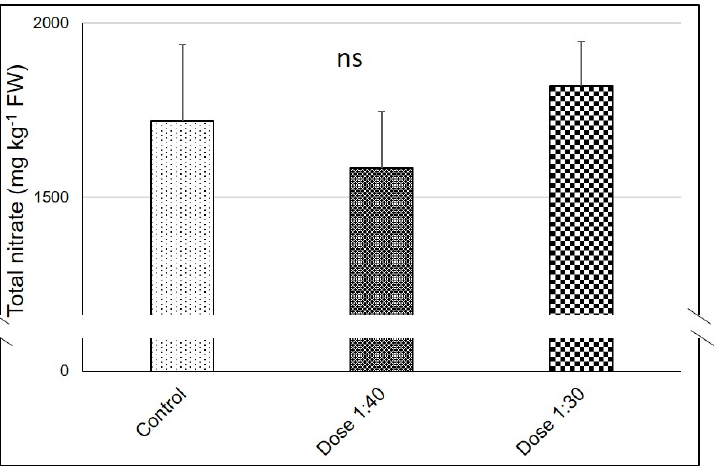
Figure 2. Effect of Moringa oleifera leaf extract (MLE) foliar application on total sugars ( a ) (mg g − 1 FW) and ascorbic acid (Asc) ( b ) (mg g − 1 FW) of radish baby leaf. Data are means ± standard error ( n = 3). Three biological replicates were used for the analysis. Different letters indicate significance at p < 0.05 according to Tukey’s Test; ns, not significant.